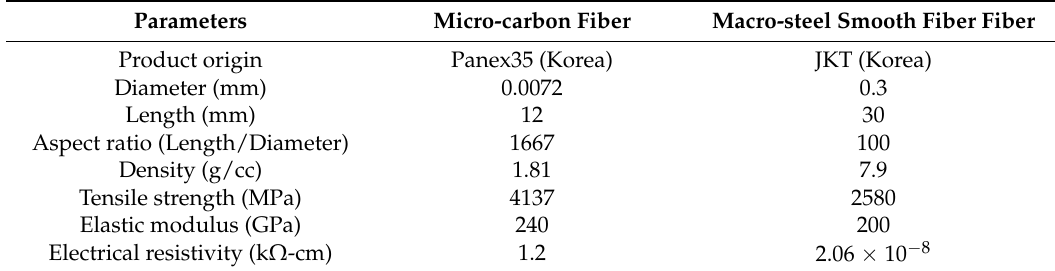
Table 2. Properties of macro-steel smooth fibers and micro-carbon fibers.